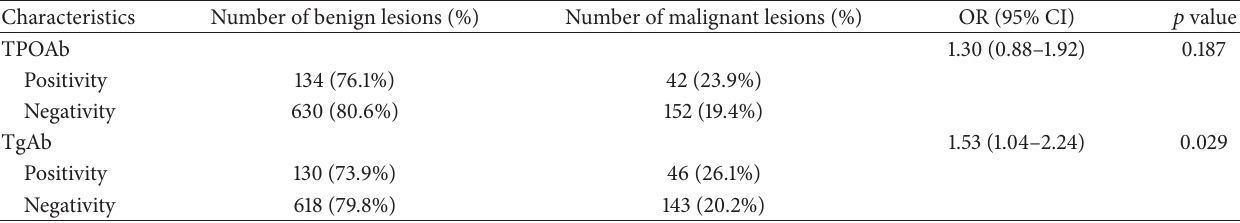
Table 4: Prevalence of thyroid cancer according to antibodies.